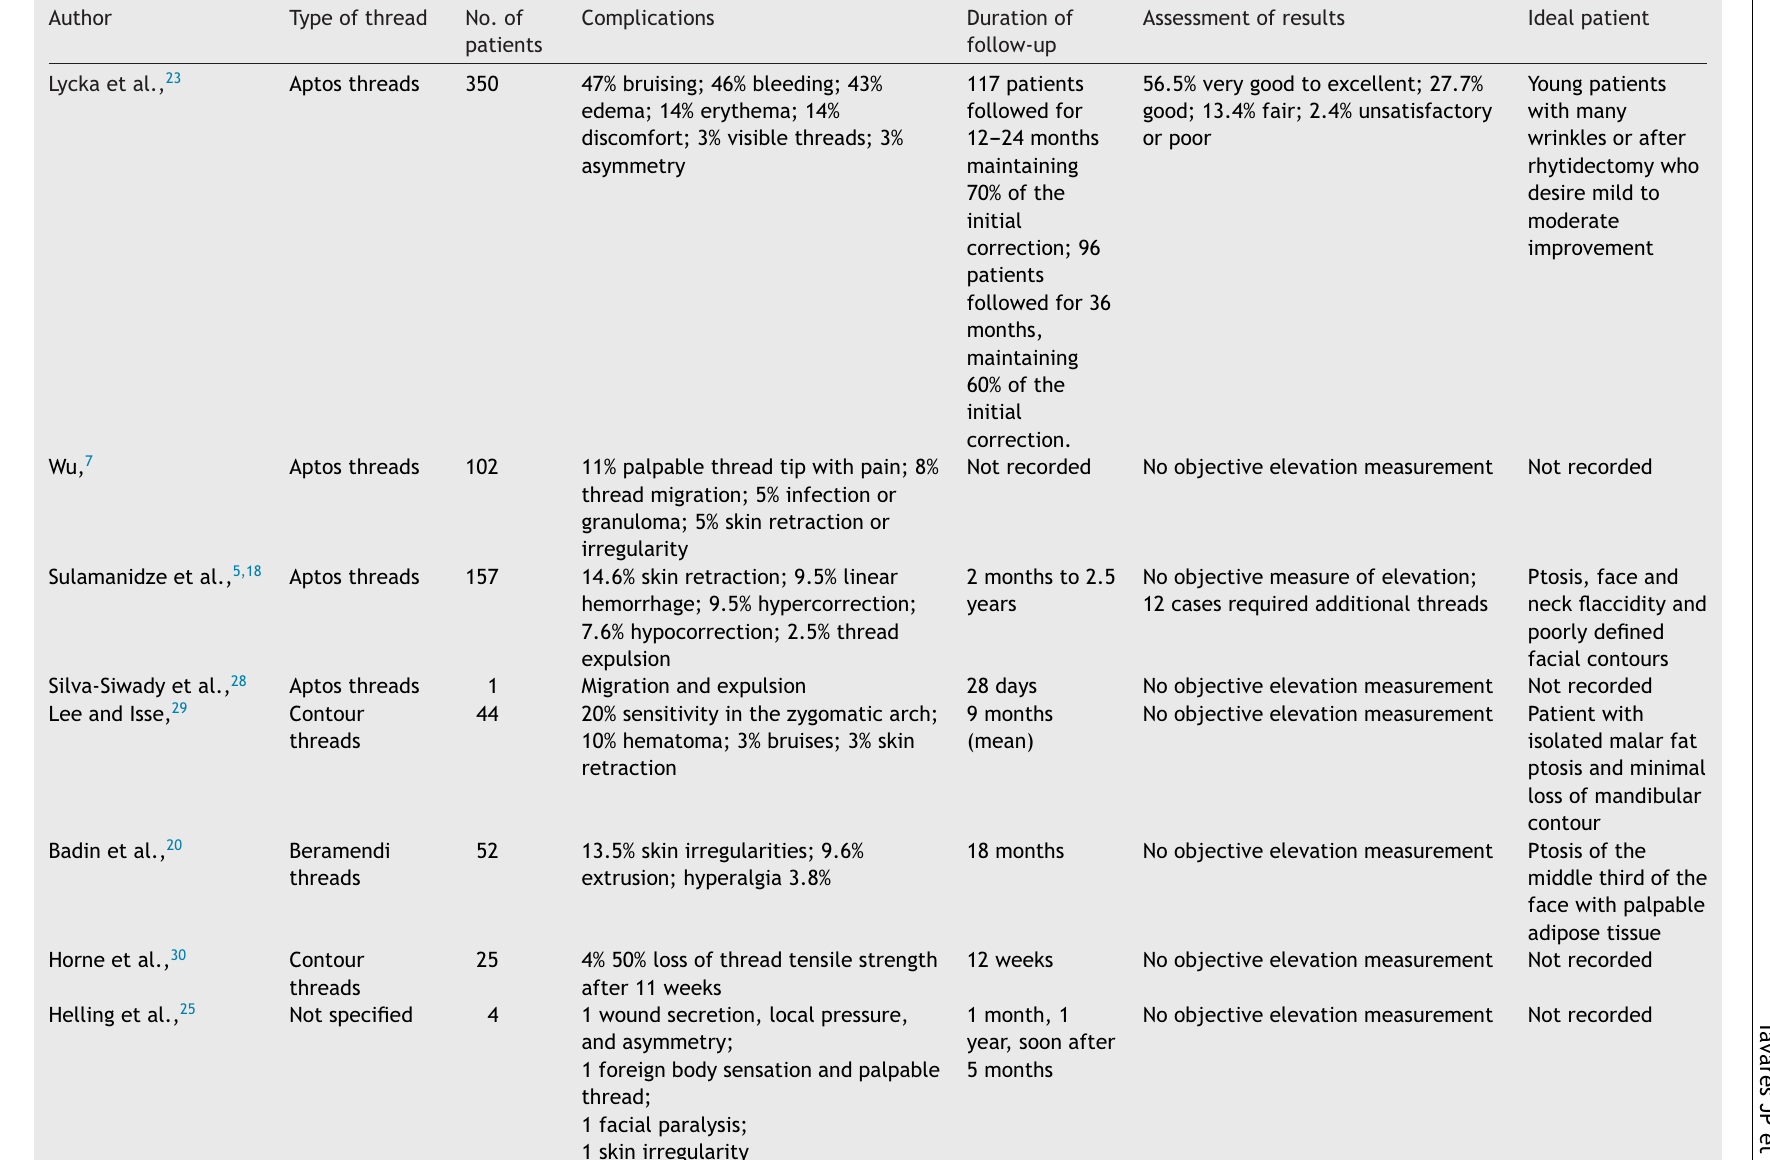
Review of the series of cases of patients submitted to facelift with barbed